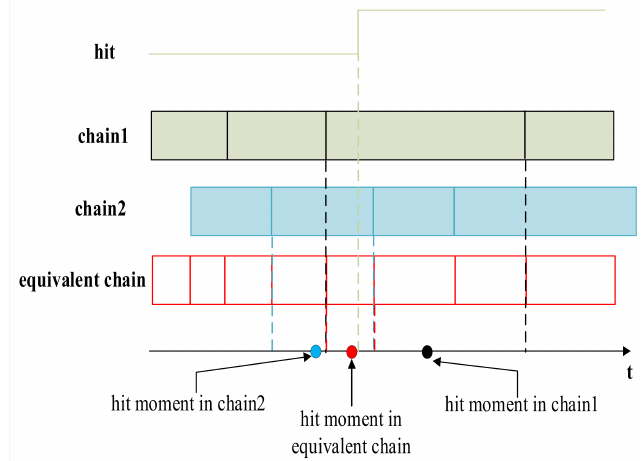
Figure 15. Point to the hit moment on time axis of different chain.